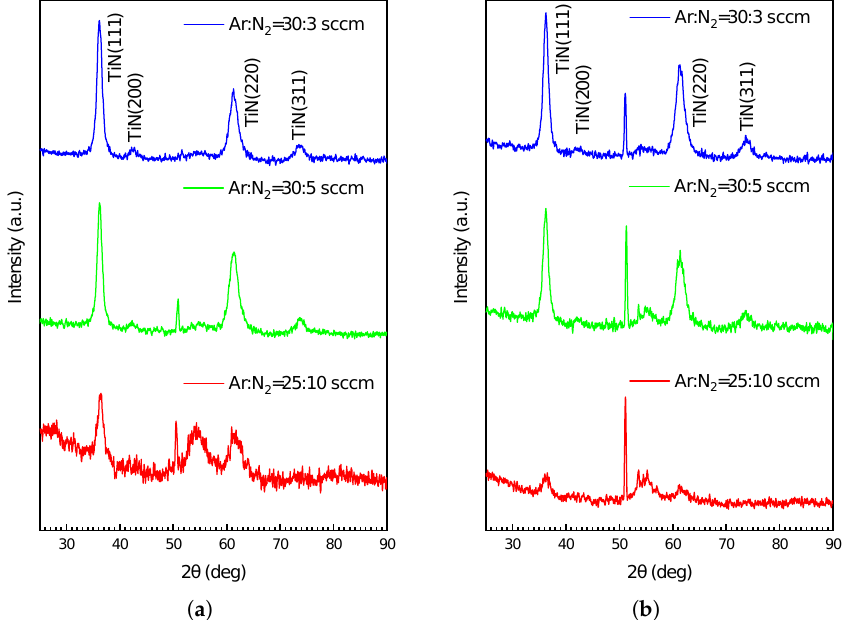
Figure 2. Grazing incidence X-ray diffraction (GIXRD) spectra of as-deposited TiN thin films pro- cessed under different Ar:N 2 gas flow rates on ( a ) Si and ( b ) SiO 2 /Si